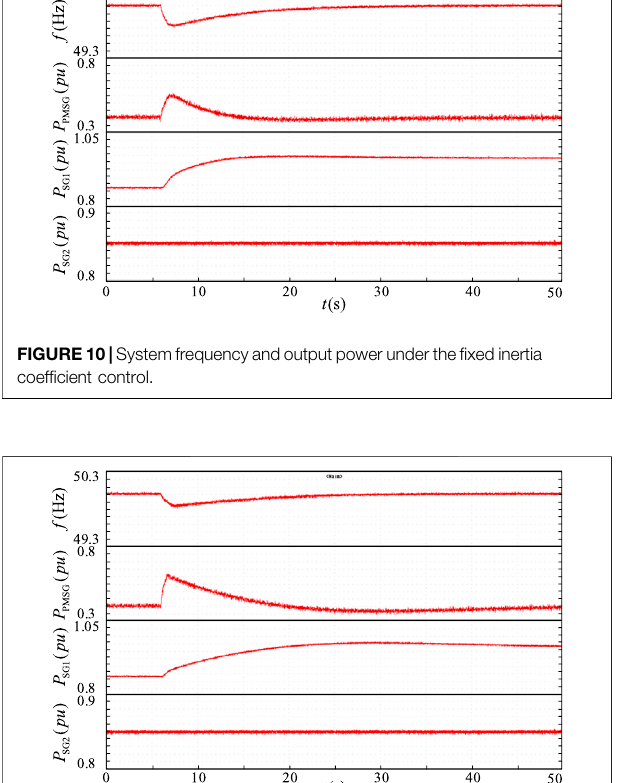
TABLE 2 | System and control parameters. Parameter name